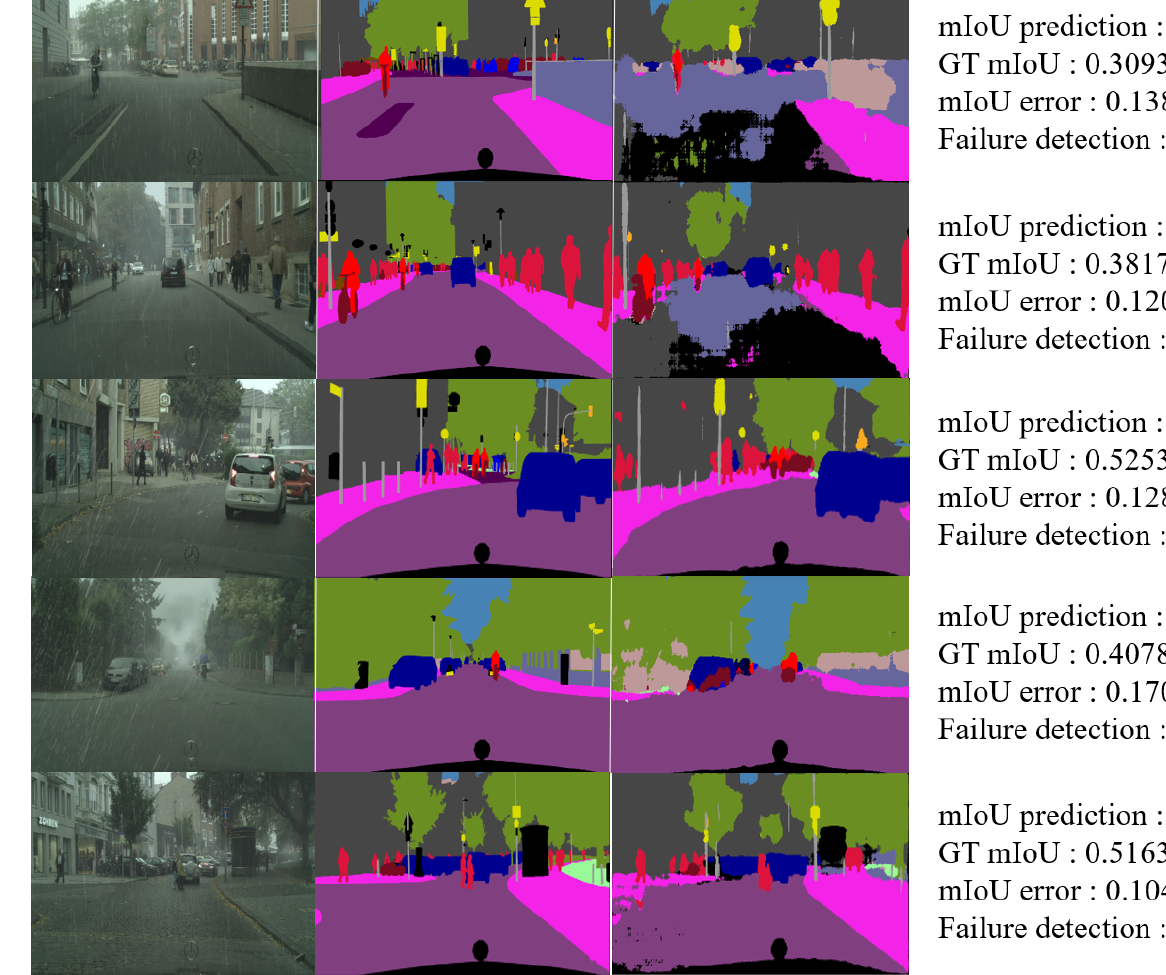
Figure 13. Examples of failure-case images in the Cityscapes rain/haze dataset.